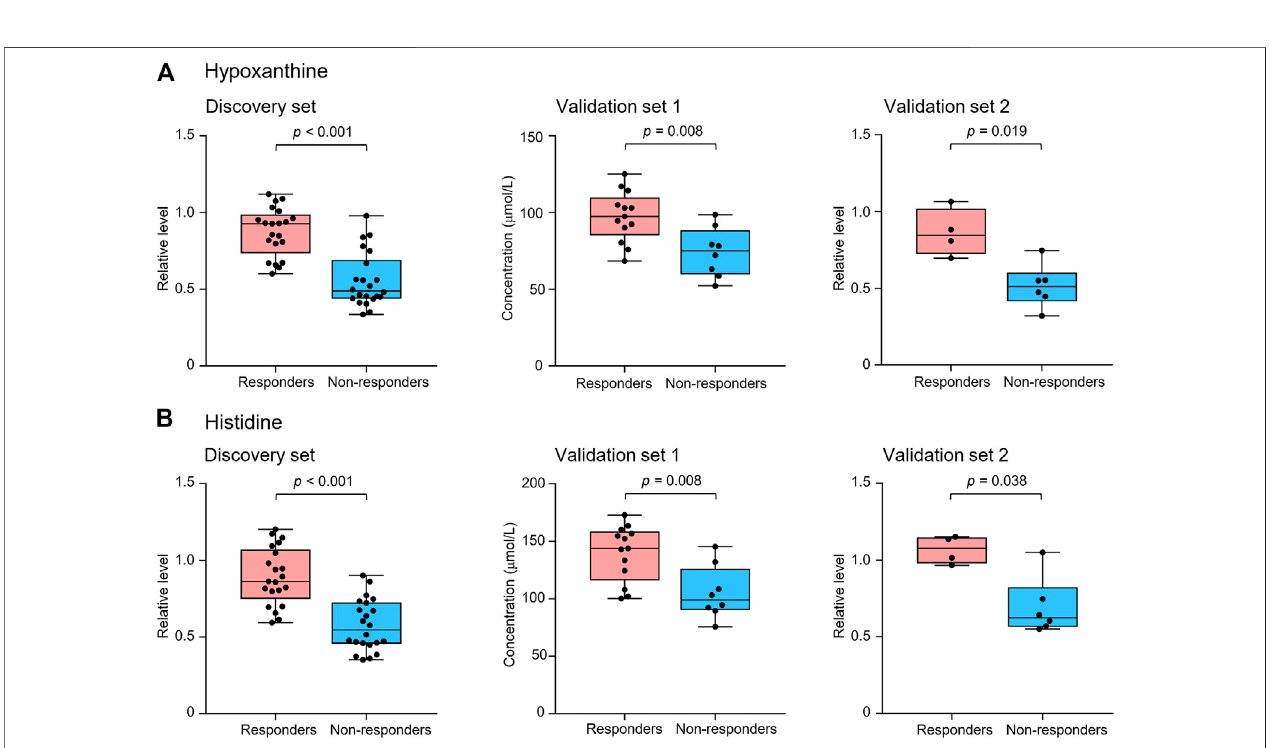
FIGURE 2 | Serum levels of potential marker metabolites hypoxanthine (A) and histidine (B) at early on-treatment in responders and non-responders of the discovery set and validation sets 1 and 2. The box plots depict the minimum and maximum values (whiskers), the upper and lower quartiles, and the median. Groups were compared by Wilcoxon-Mann-Whitney test with Benjamini-Hochberg-based adjustment for multiple comparisons.